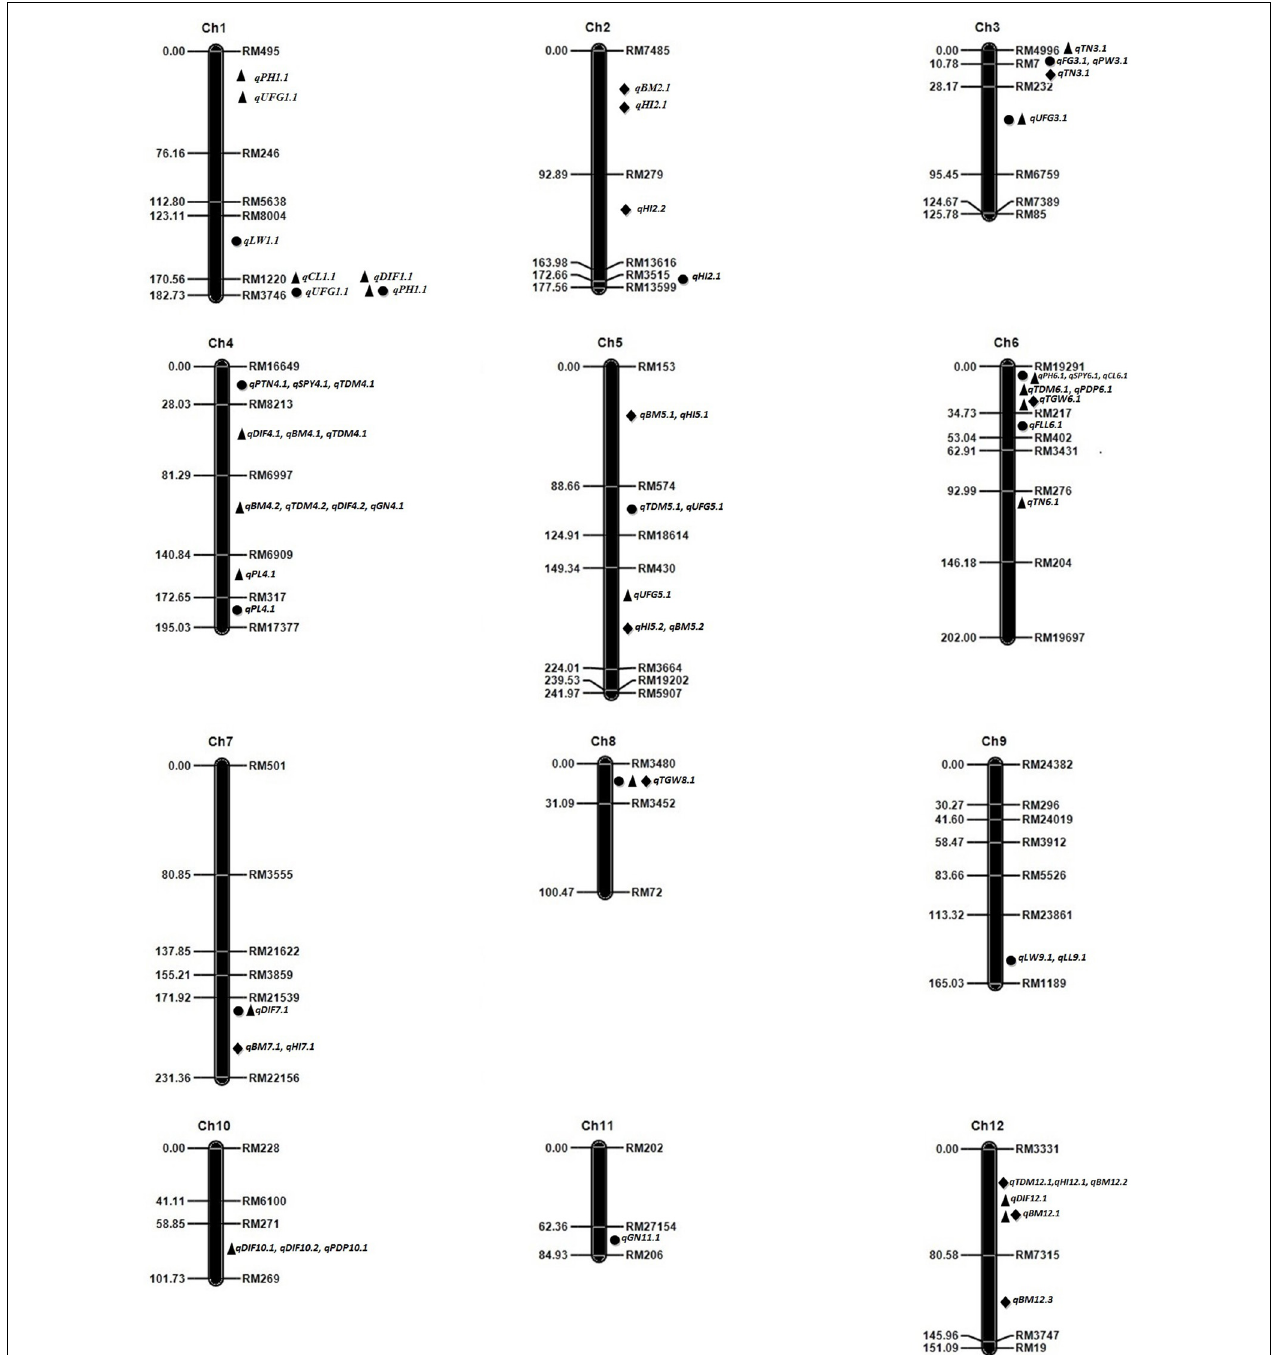
FIGURE 2 | Molecular linkage map of 12 chromosomes with position of Quantitative Train Loci (QTLs) for yield-related traits in F 2 : 3 : 4 generations detected using ICIM. QTLs named by trait abbreviation and chromosome number, (cid:108) – F 2 generation, (cid:78) – F 3 generation, (cid:7) – F 4 generation. DIF, days to initial flowering; PH, plant height; PTN, productive tiller number; SPY, single plant yield; TDM, total dry matter; HI, harvest index; PL, panicle length; FG, filled grains; UFG, unfilled grains; GN, grain number; PW, panicle weight; TGW, thousand-grain weight; PDP, per day productivity; BY, bulk yield; FLL, flag leaf length; LL, leaf length; LW, leaf width.